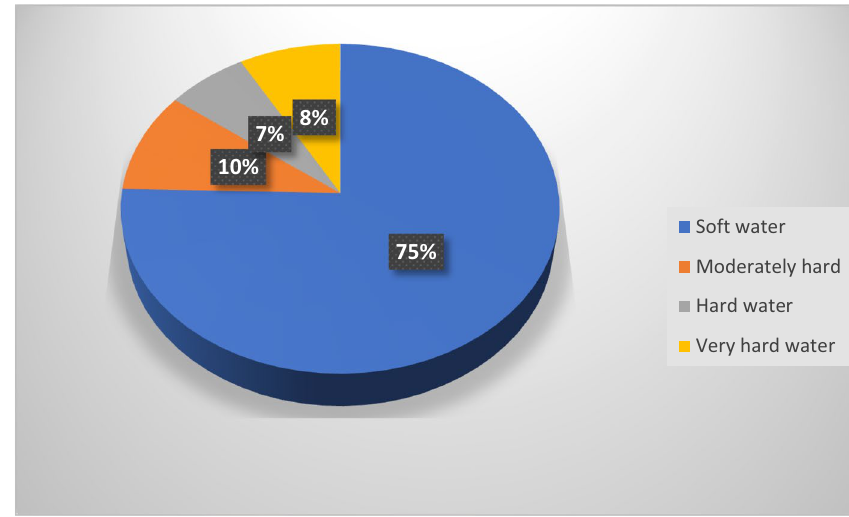
Fig. 3 Hardness of water in the study area